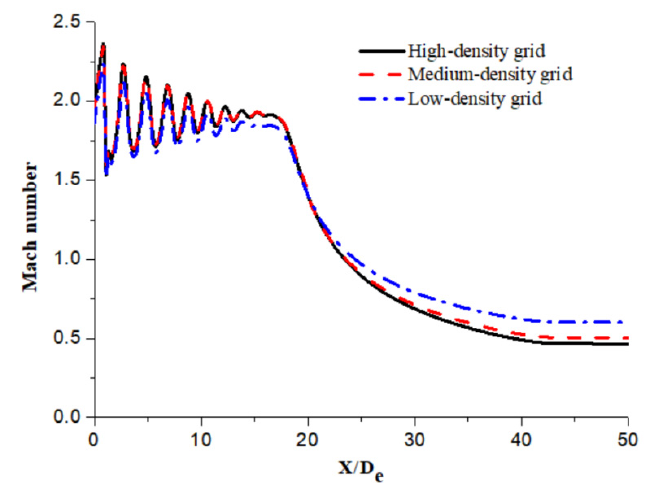
Figure 4. Axial Mach number distribution for various grid densities.